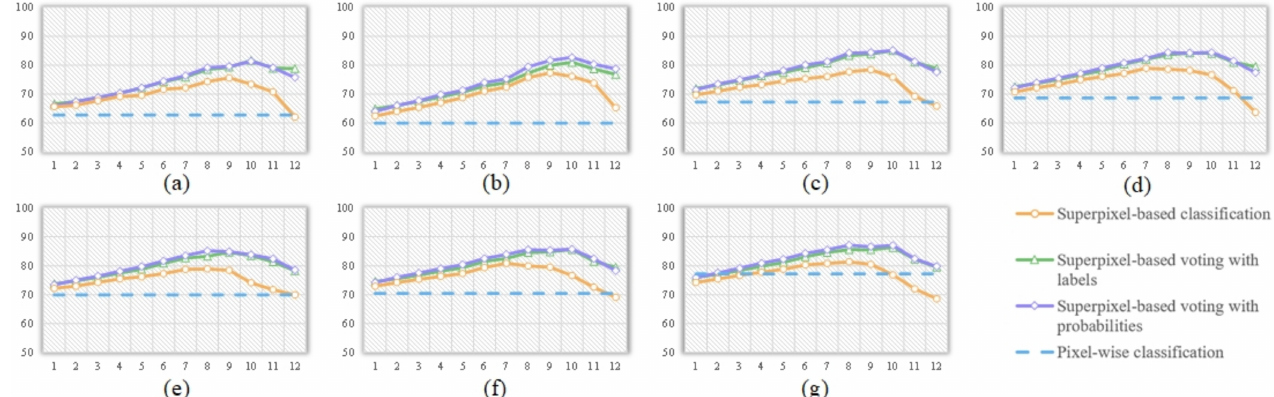
Figure 10. Accuracies given by the single-scale approaches with ( a ) 25, ( b ) 50, ( c ) 100, ( d ) 150, ( e ) 200, ( f ) 250, and ( g ) 300 training samples per class for the Honghu dataset using RF, where the vertical axis represents the OAs, and the horizontal axis represents the superpixel segmentation